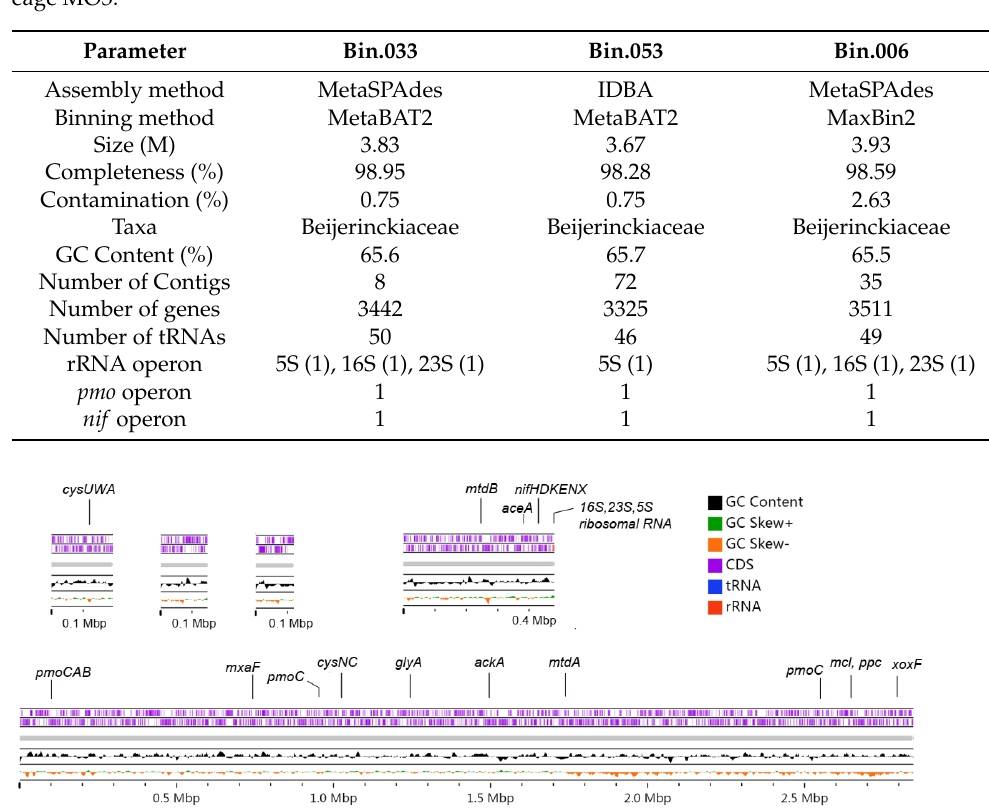
Figure 2. Main contigs of the reconstructed metagenome-assembled genome (MAG) of the pmoA lineage MO3 (MO3_YZ.1, Bin.033). The forward and reverse coding regions (CDS) of the five large contigs contained in this MAG were shown. Some genes encoding the key enzymes involved in carbon, nitrogen, and sulfur metabolism are marked in the outermost rings. Table S4 shows the full names of enzymes encoded by these genes. The other three contigs less than 30k in length were not shown.